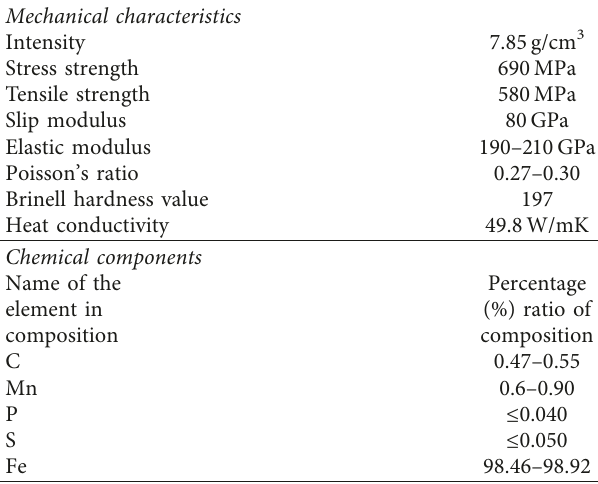
Figure 1: Experimental setup: (a) CNC milling machine, (b) 5233A-type dynamometer, and (c) computer. T ABLE 1: Mechanical characteristics and chemical components of AISI 1050 alloy